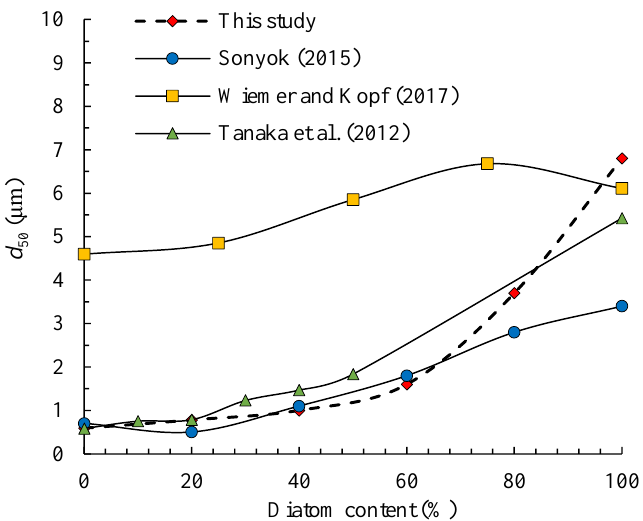
Figure 14. Relationship between average particle diameter d 50 and diatom content. Data sources: DKMs [6,19,32].